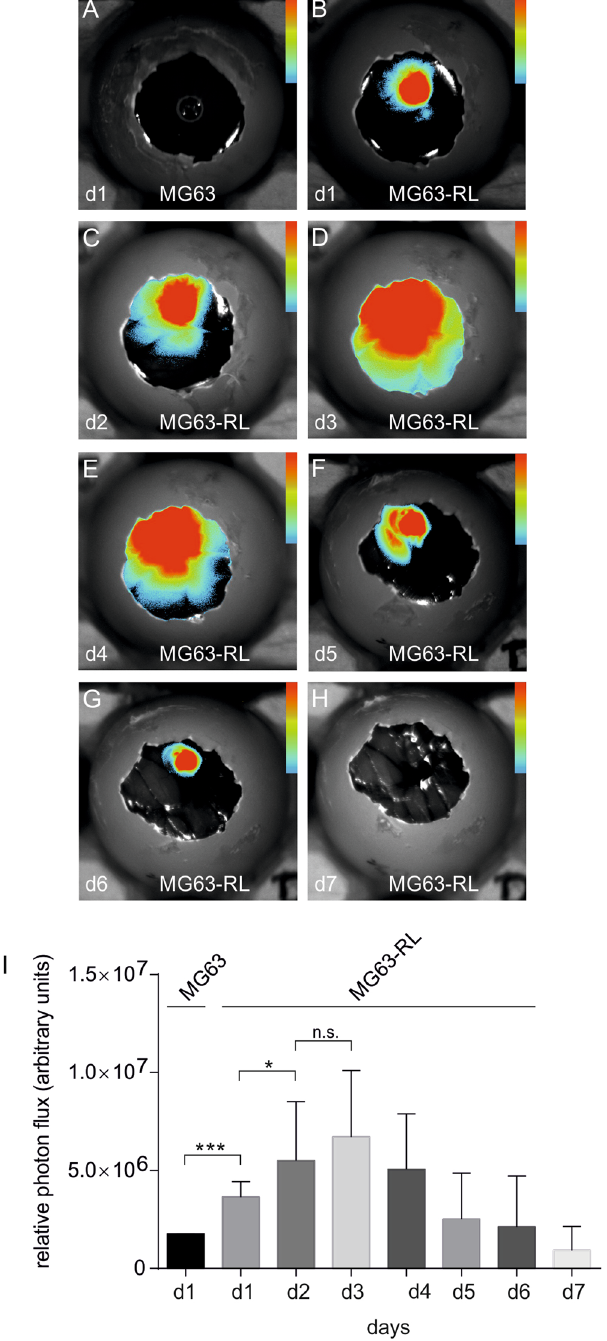
Figure 5. BLI of engineered osteosarcoma-gelfoam scaffolds in the living chick embryo. ( A ) In vivo egg BLI of MG63-gelfoam control scaffolds. ( B – H ) Representative images of daily in vivo egg BLI of MG63-R-gelfoam scaffolds over a course of 7 days. ( I ) Corresponding quantitative BLI analysis expressed as means with standard deviation for the group n = 13. All color bar inserts range from 0 (blue) to 16383 (red) units photon flux. * p < 0.05, *** p <